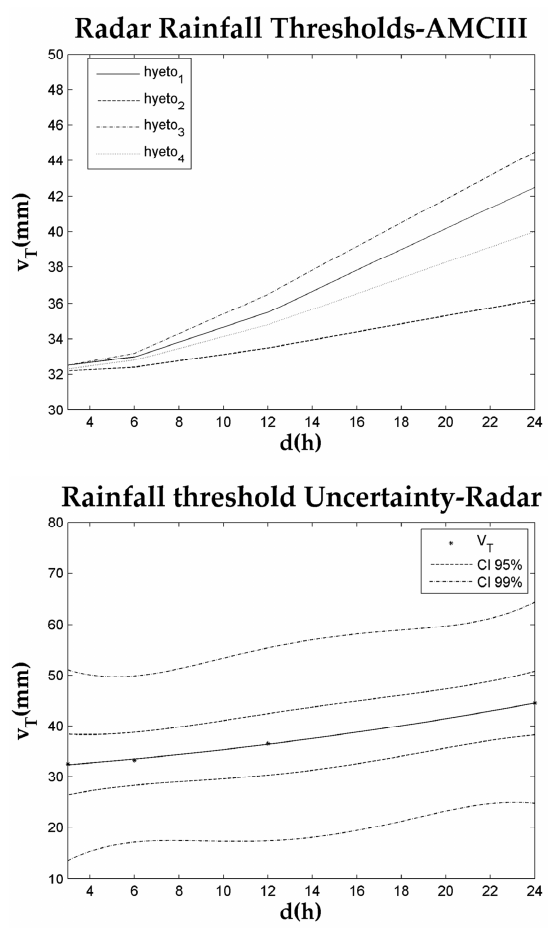
Fig. 8. Threshold values evaluated by hydrological model calibrated with radar data for AMCIII soil conditions (upper panel) and uncer- tainty associated with hyeto 1 threshold for the Mignone River basin (lower panel).